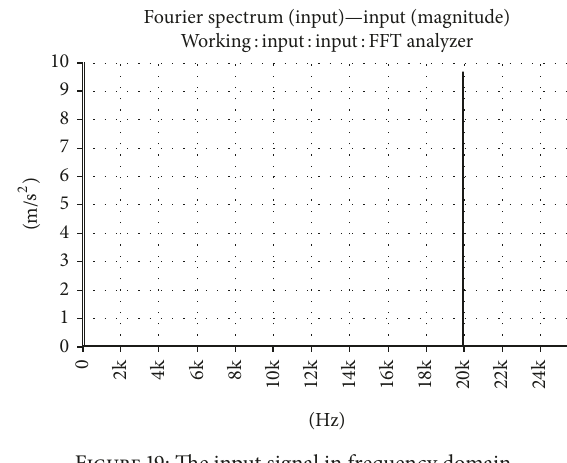
Figure 17: The input signal in time domain.